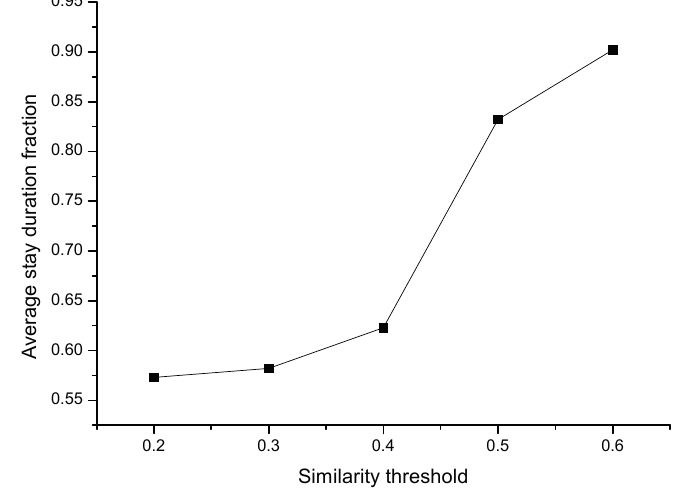
Figure 6. The average stay duration with different similarity